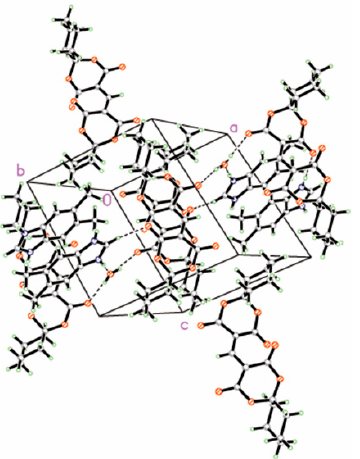
Figure 3. Packing diagram of DBH with 30% probability thermal ellipsoids.